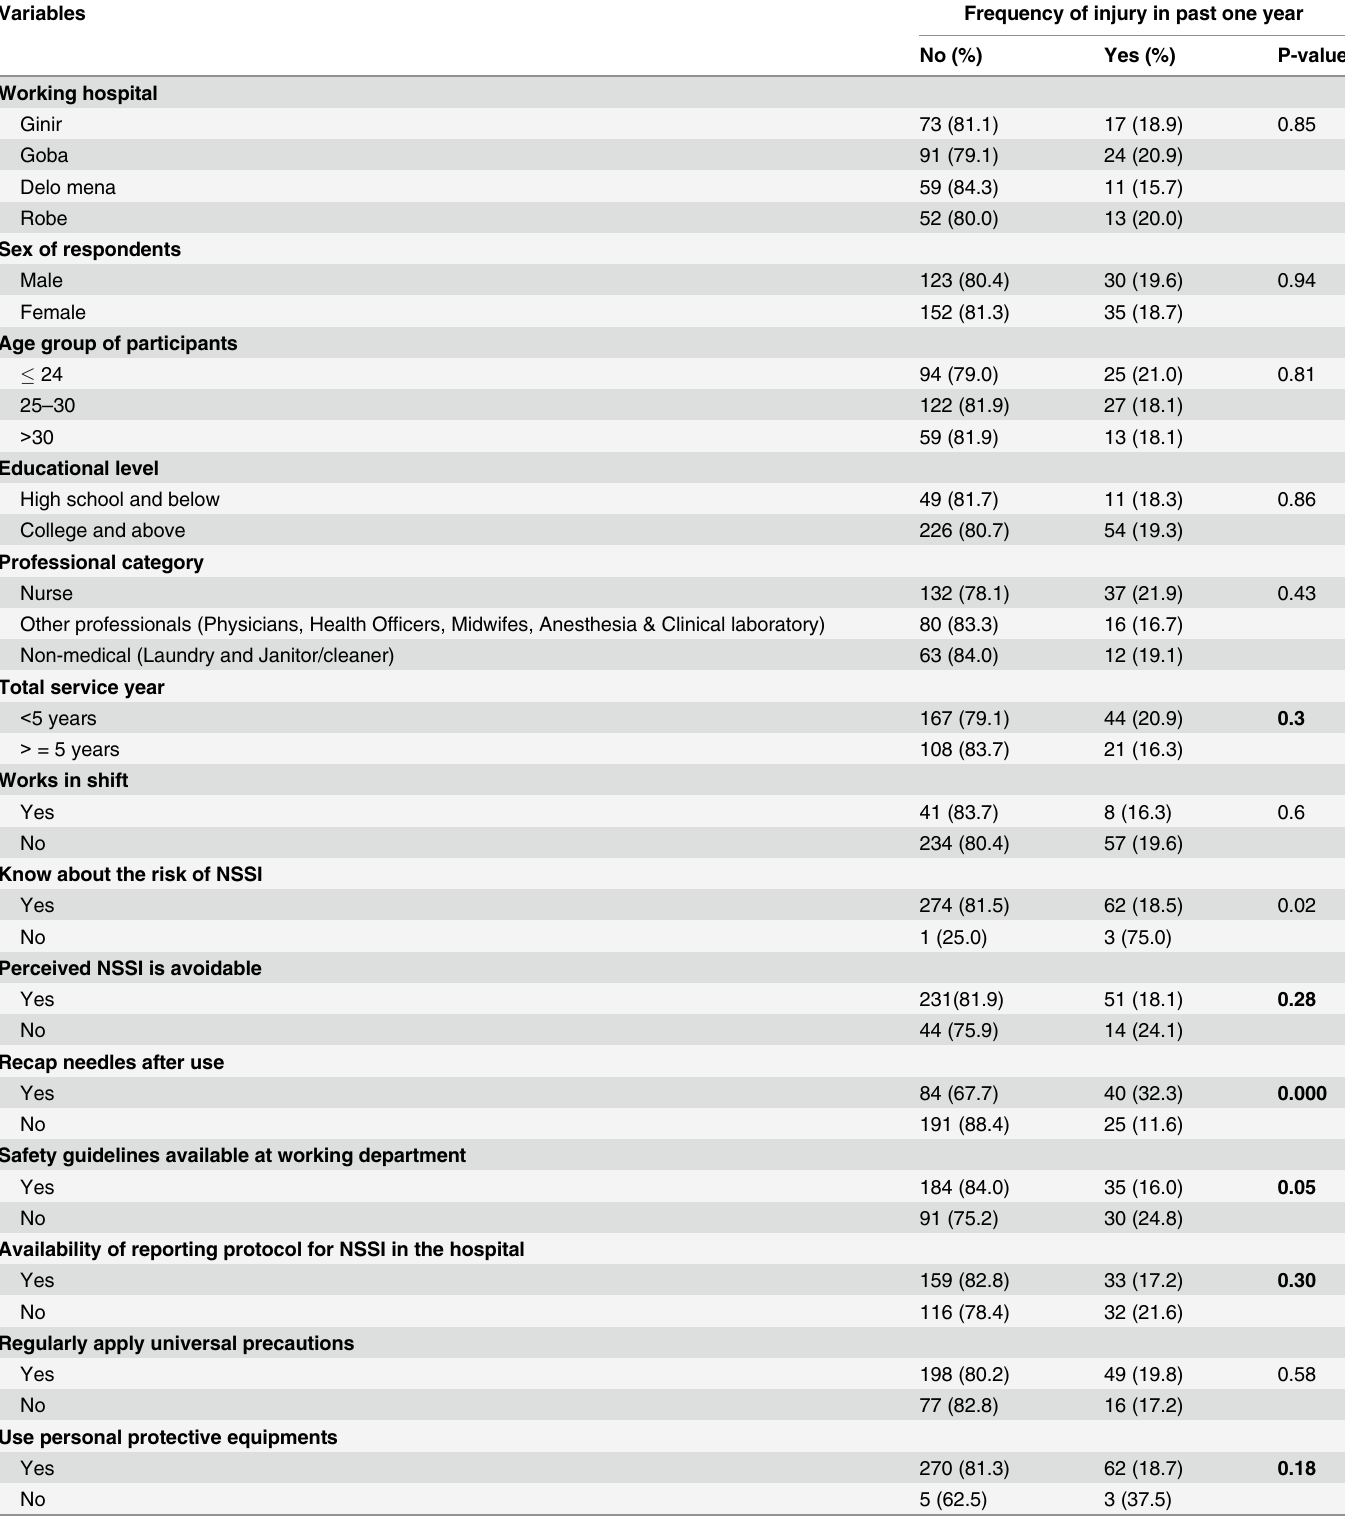
Table 3. Cross-tabulation of prevalence of NSSI within the past one year among HCWs in Bale zone hospitals, December, 2014 (n = 340).